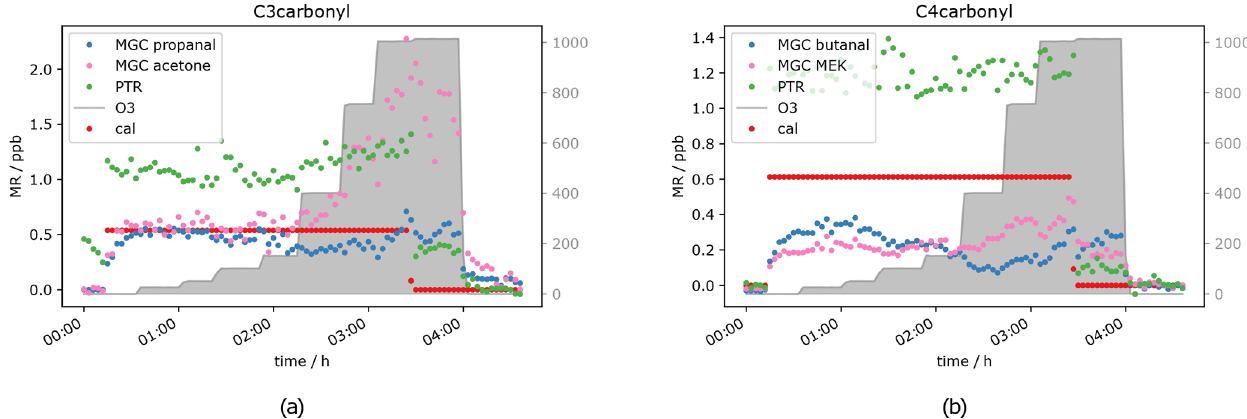
Figure 6. C 3 and C 4 carbonyl mixing ratios at approximately 0.5ppb per VOC at different ozone levels.